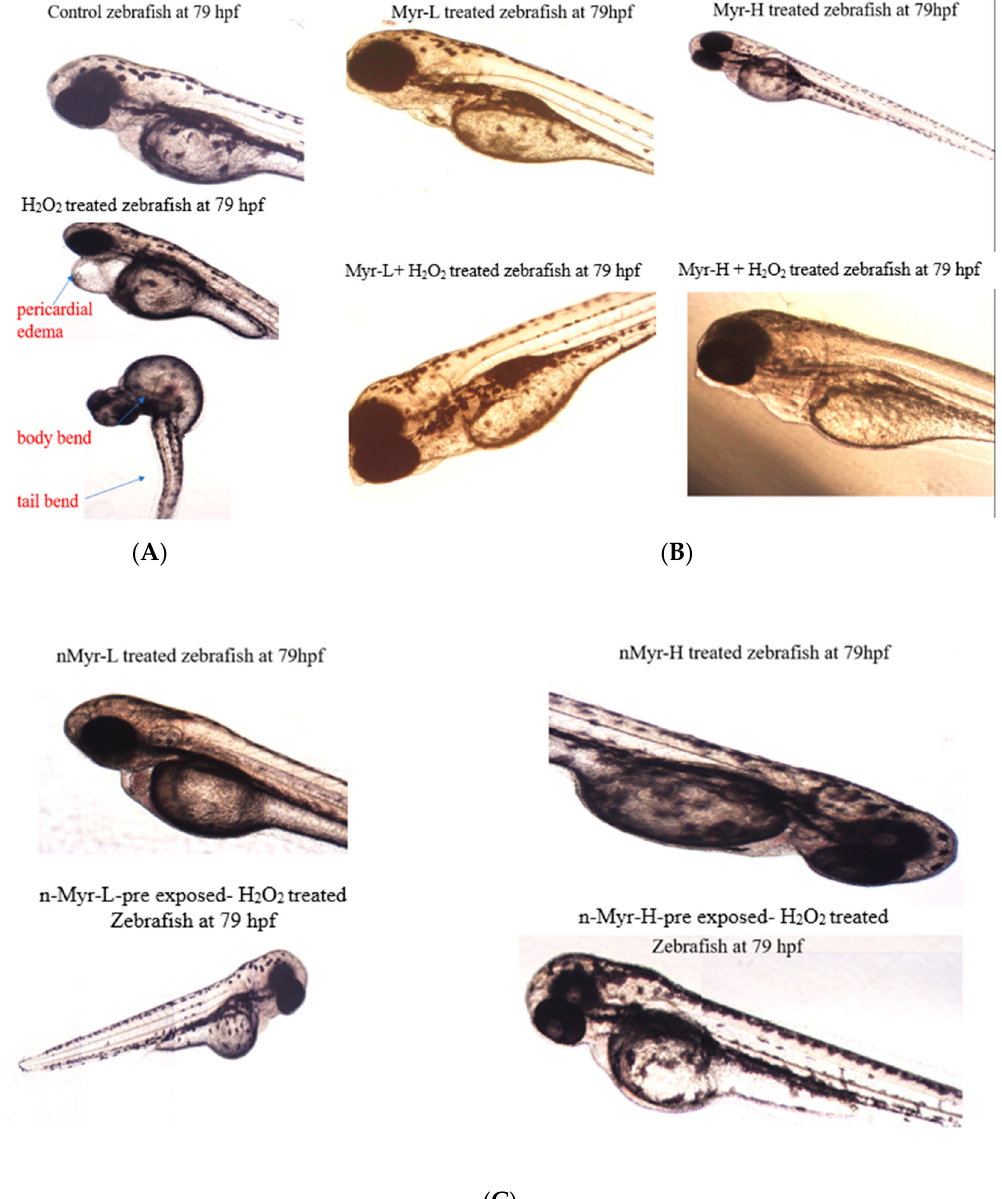
Figure 7. Microscopic images of zebrafish embryos at 79 hpf with developmental disabilities. ( A ) Control embryos and H 2 O 2 ‐ treated embryos with abnormalities with pericardial edema, tail bend, and body bend. ( B ) The zebrafish embryos were treated with low and high doses of myricetin as well as pre ‐ treated with myricetin followed by H 2 O 2 treatment. ( C ) Zebrafish embryos were treated with low and high doses of nano ‐ myricetin followed by hydrogen peroxide treatment. The embryos treated with only hydrogen peroxide without any pre ‐ treatment with myricetin or nano ‐ myricetin were taken as controls.